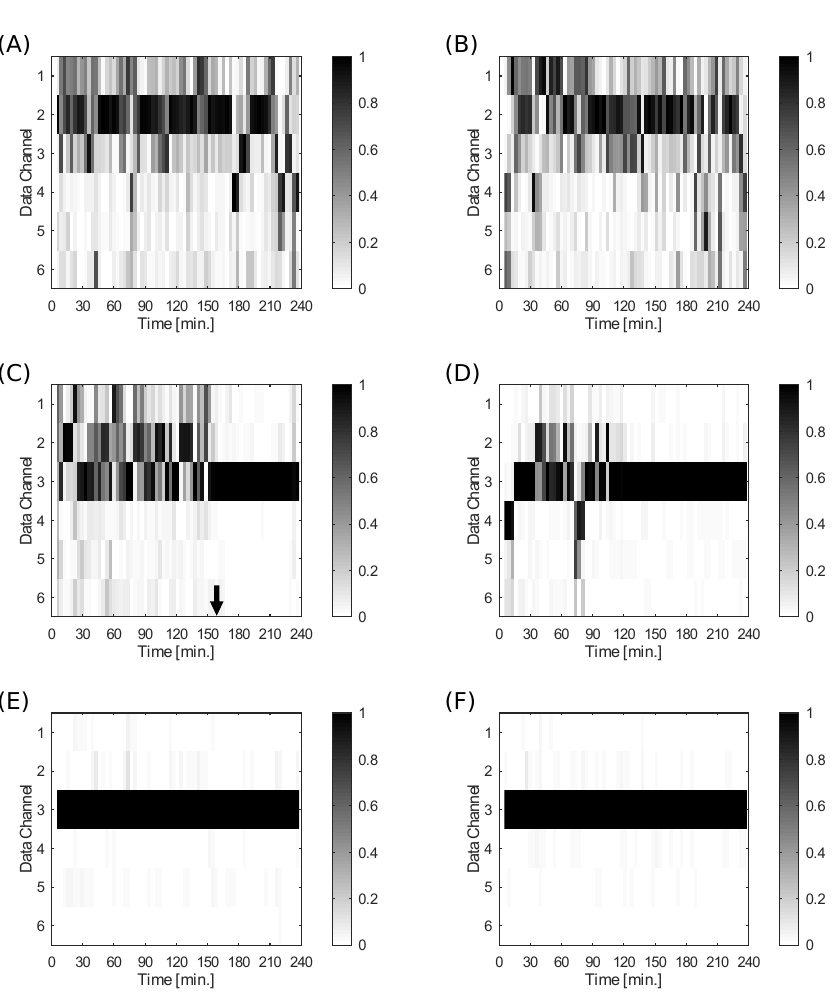
Figure 6. Transition of the eigenstate around the Mie earthquake for ( A ) 2016/091/16-19, ( B ) 2016/091/20-24, ( C ) 2016/092/00-04, ( D ) 2016/92/04-08, ( E ) 2016/92/08-12, ( F ) 2016/92/12-16. The down arrow shows the time the earthquake